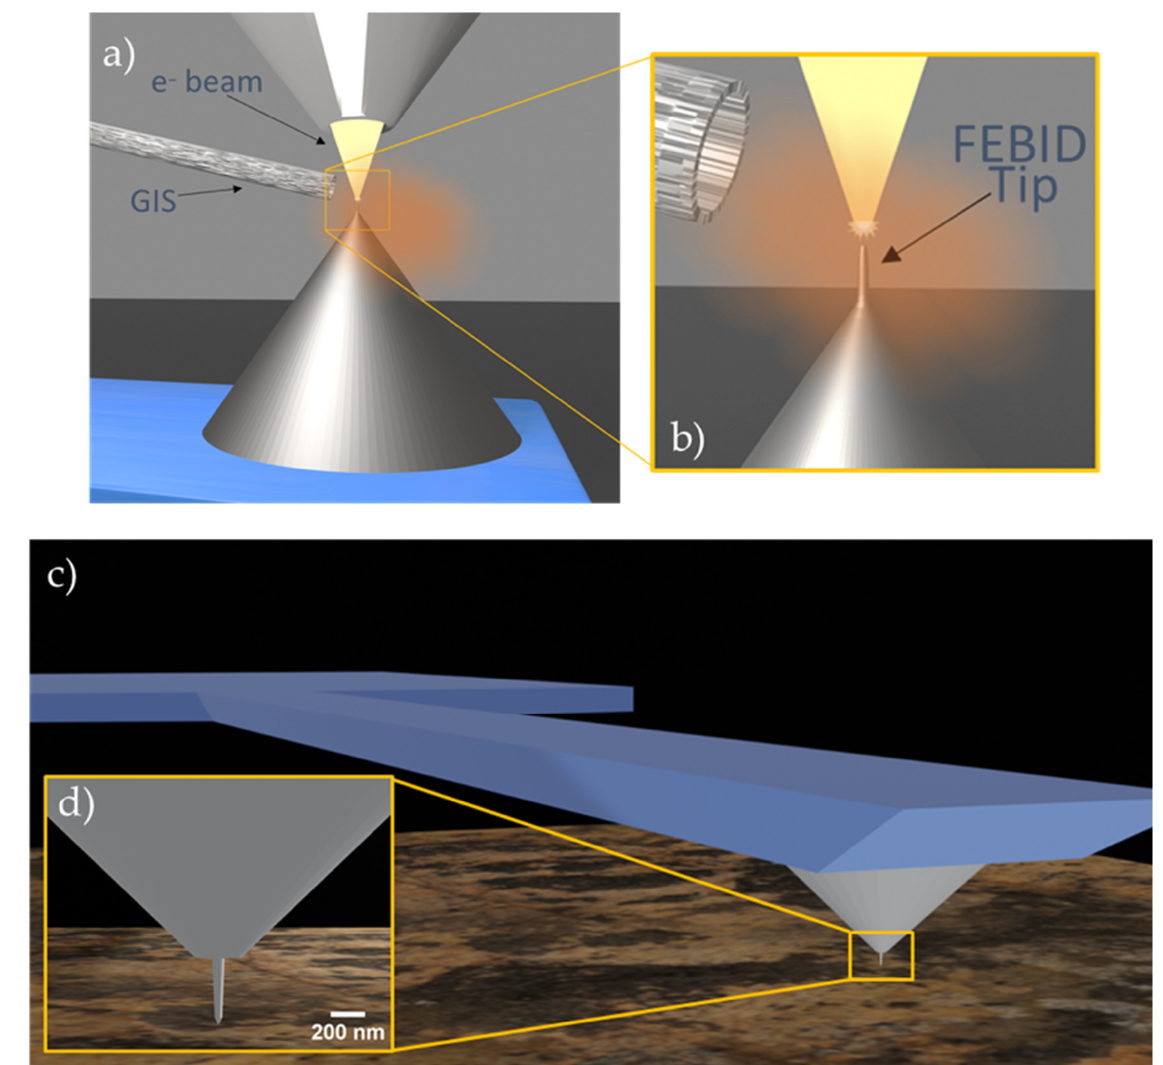
Figure 1. Schematic representation of the FEBID magnetic tip during the growth process ( a , b ) and the MFM measurement ( c , d ). ( a ) Overview of the deposition process of Fe tips by FEBID on the apex of a commercial AFM tip. ( b ) Detailed view of the growth process of the Fe tip, in which the GIS delivers the gas precursor during the electron beam irradiation, producing a vertical deposit on the apex of the AFM tip. ( c ) Wide view of the functionalized cantilever. ( d ) Detail of the cantilever tip, which shows the size ratio of AFM tip and the FEBID deposit. Commercial tips have an apex diameter of approximately 100 nm, whereas the tip of FEBID-grown Fe nanowire is around 15 nm